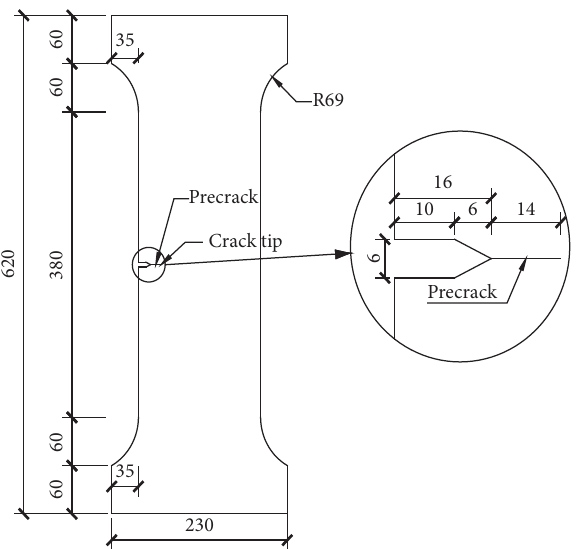
Figure 1: Dimensions of the specimen and damage (mm).